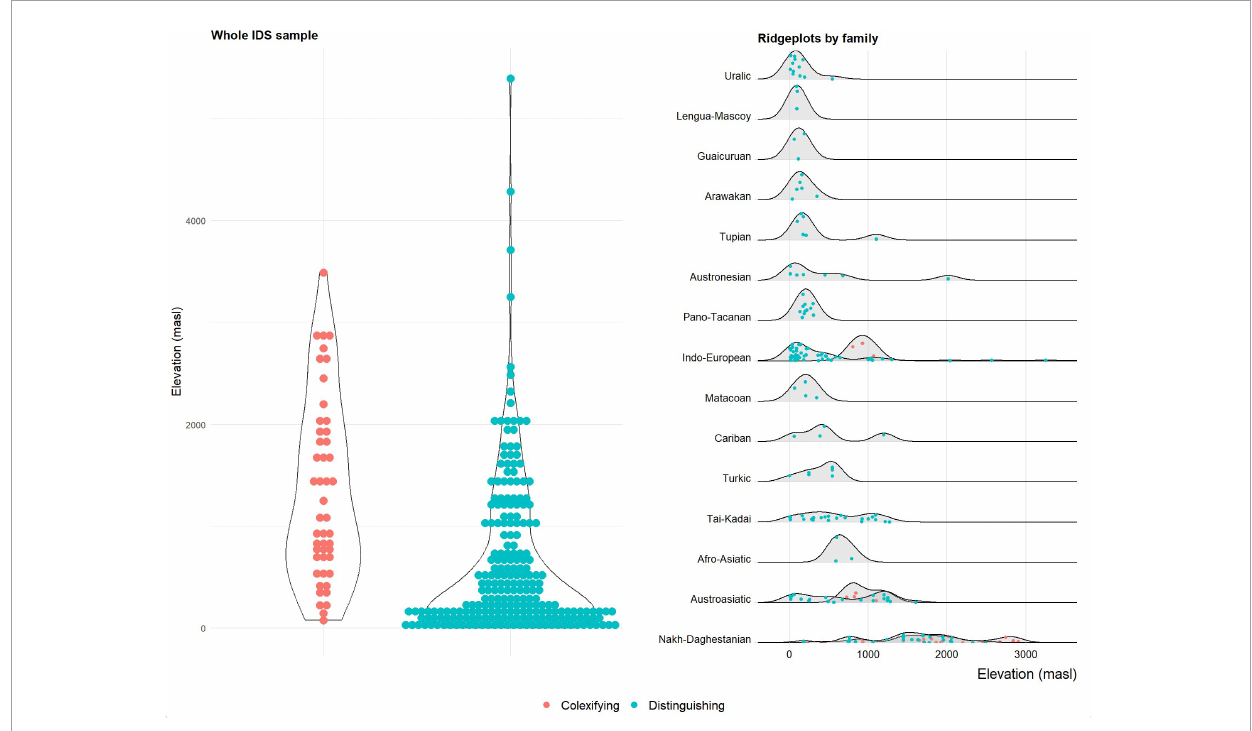
FIGURE1 Colexification and non-colexification of “cloud” and “fog” in the IDS dataset, depending on elevation.